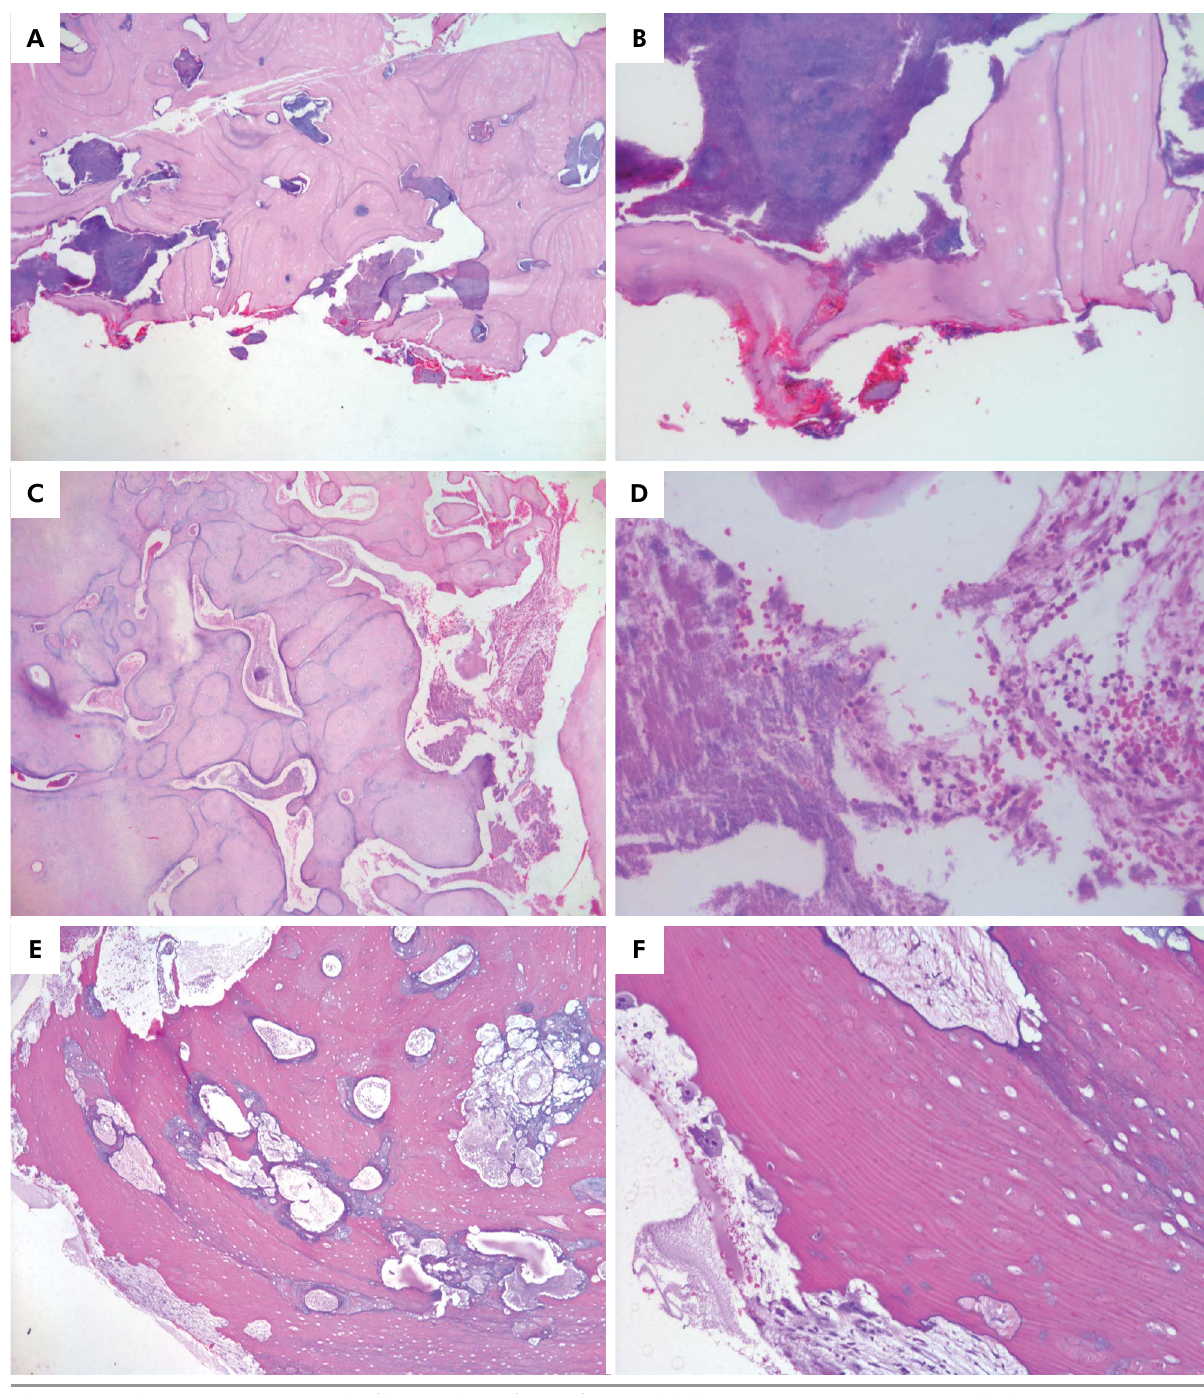
Figure 1. a, b) MRONJ – extensive biofilms on the surfaces of non-viable bone tissue; c) OMJ – Non-viable bone tissue presenting basophilic reversal lines, d) biofilm with leukocyte infiltration; and, e, f) ORNJ – Avascular and acellular bone tissue showing areas with osteoclastic activity (HE; bar = 100